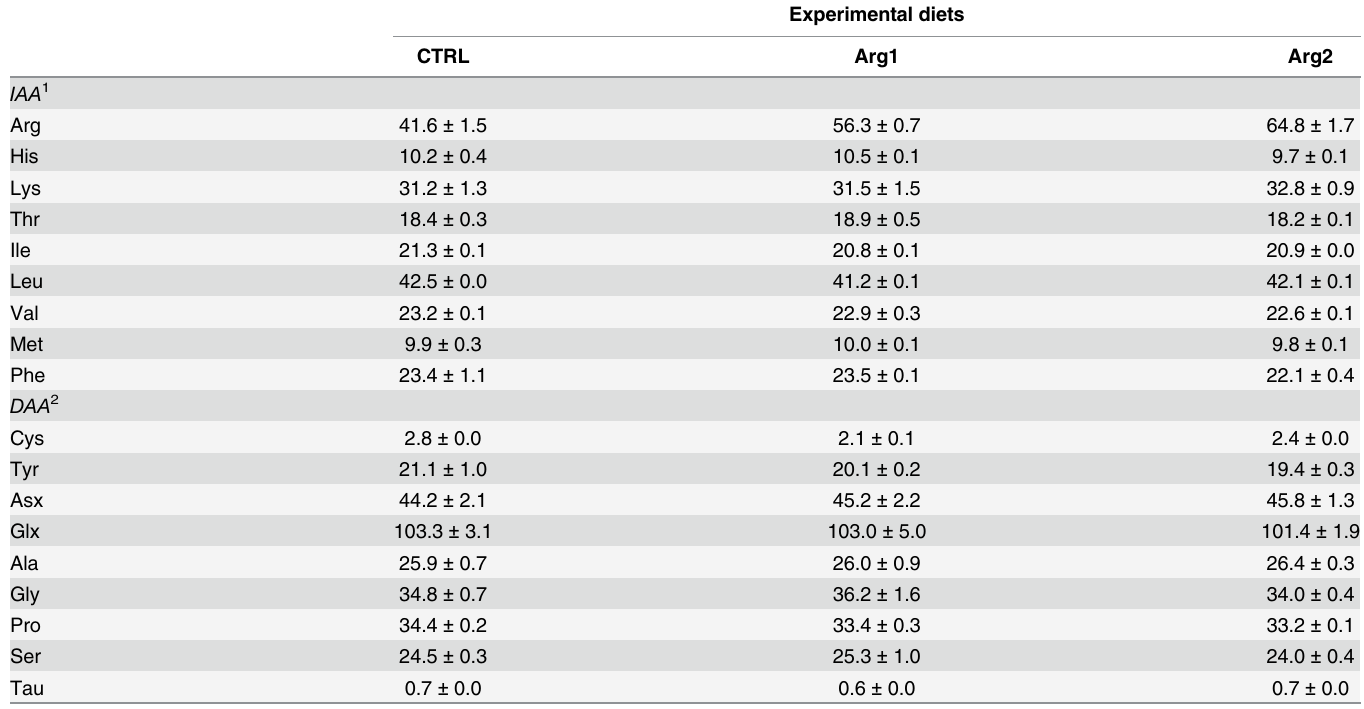
Table 2. Amino acid composition (mg/g diet) of experimental diets. Trp was not analysed. Values are means ±